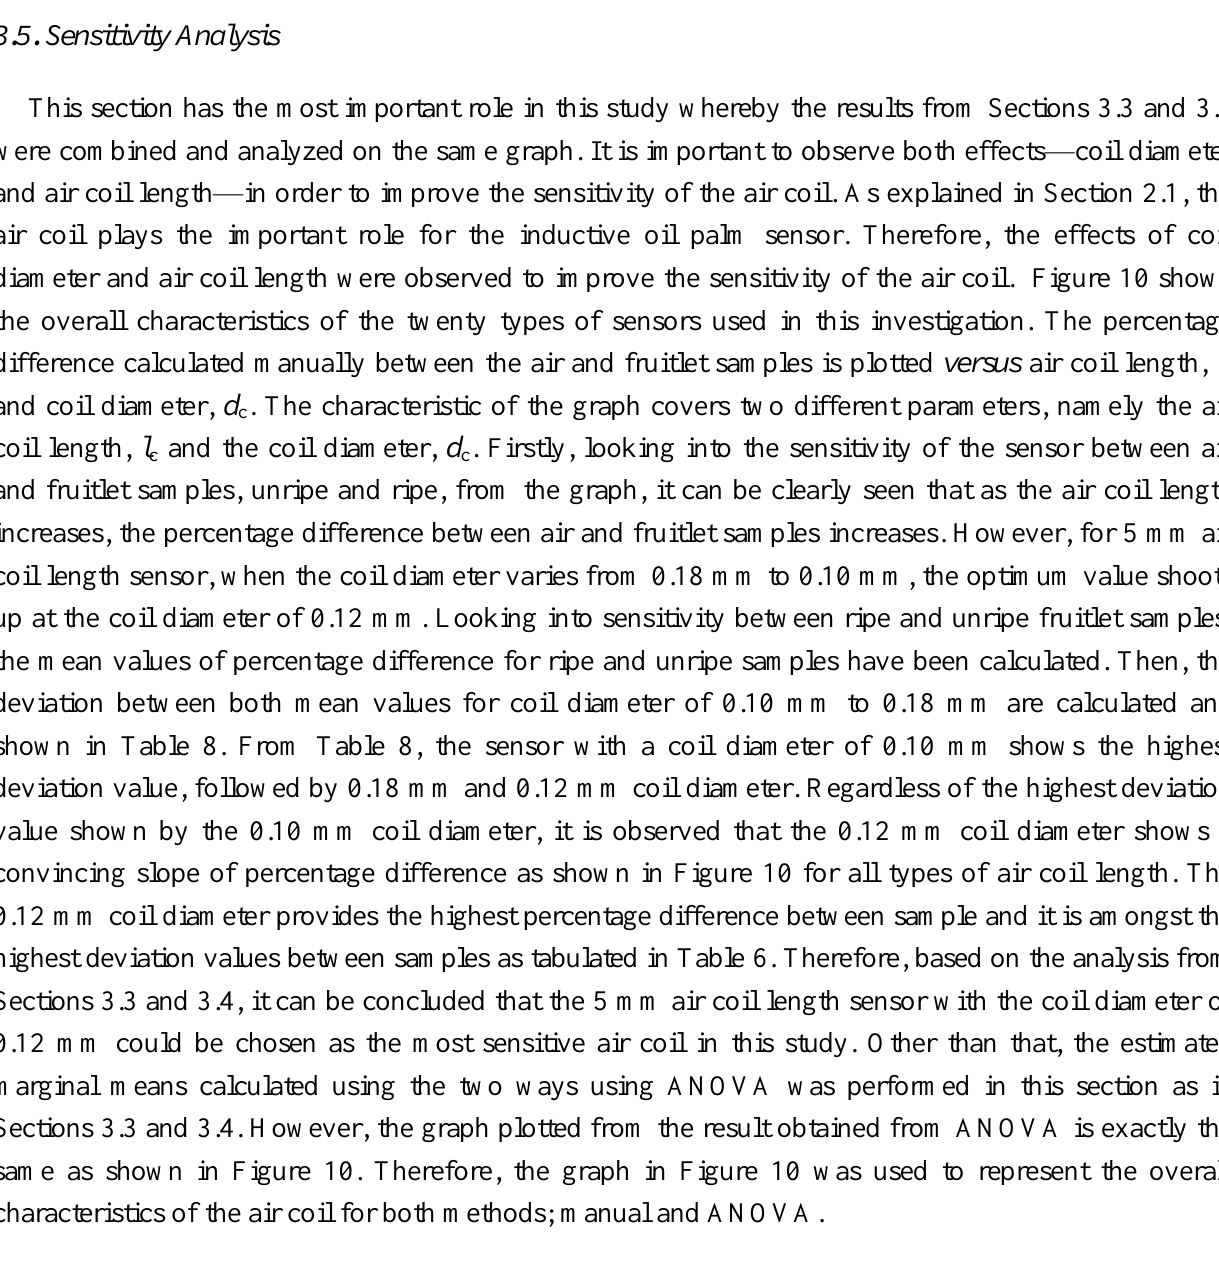
Table 8. The mean value of the percentage difference between ripe to unripe